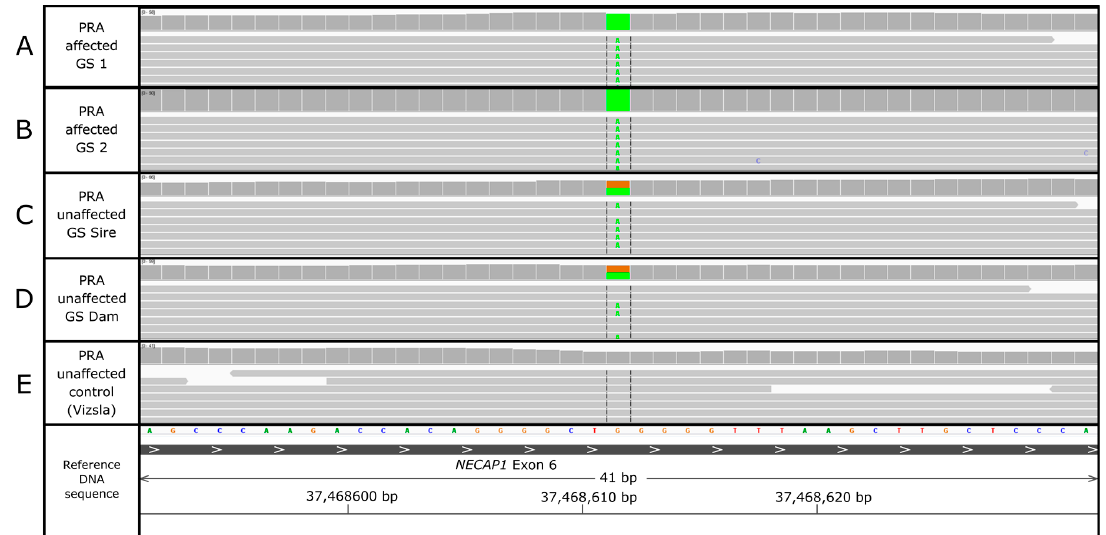
Figure 2. Whole genome sequencing (WGS) analysis in Integrative Genomics Viewer (IGV) of GS PRA cases homozygous ( A , B ) for the c.544G > A (p.Gly182Arg) single nucleotide variant (SNV) in exon 6 of 8 of NECAP endocytosis associated 1 ( NECAP1 ), una ff ected sire ( C ) and dam ( D ) heterozygous for